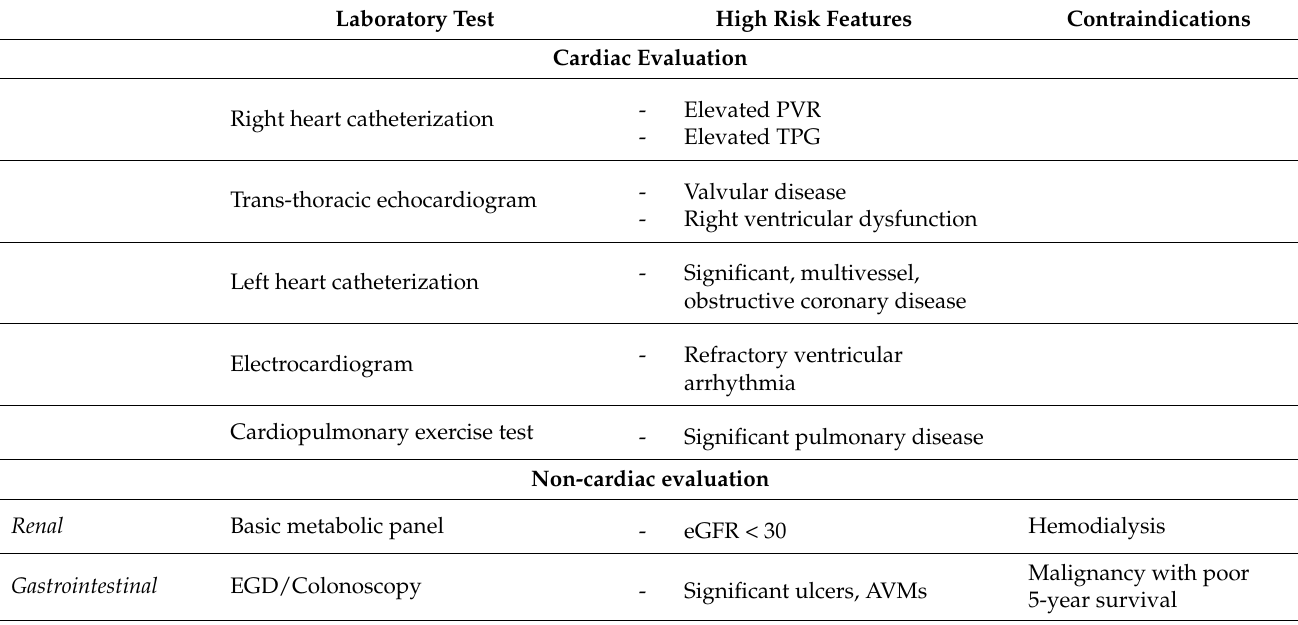
Table 1. Pre-operative evaluation of left ventricular assist device